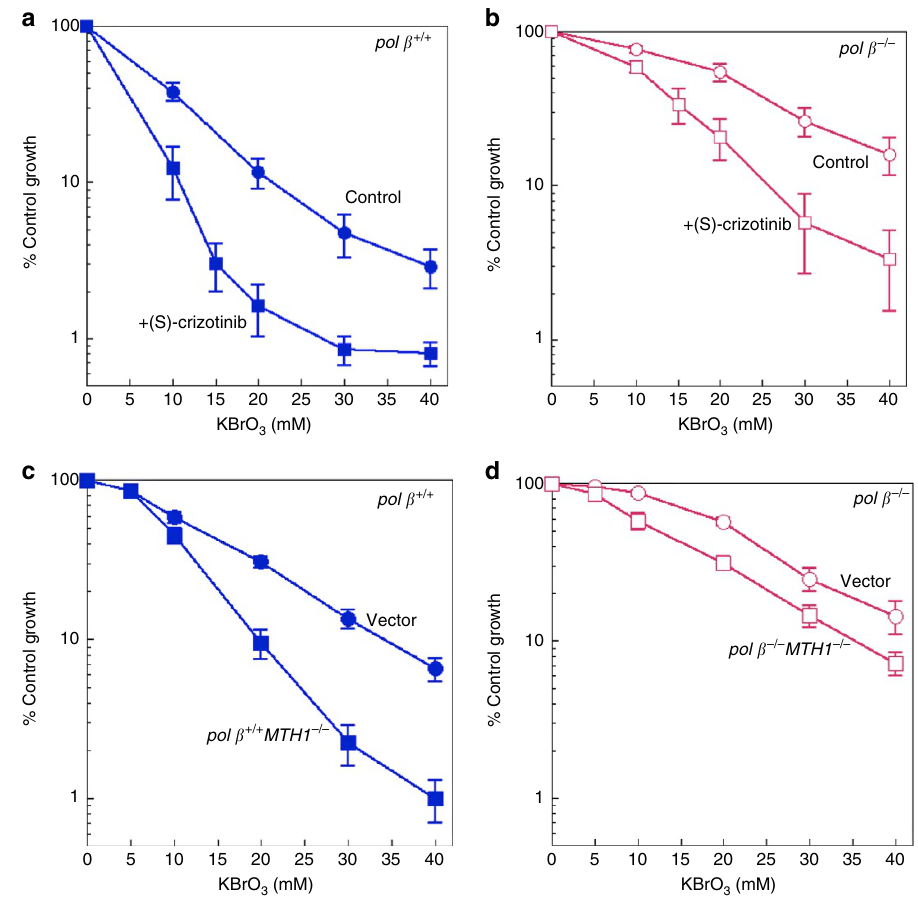
Figure 3 | Sensitivity of MEFs to oxidative stress. ( a , b ) Plots show pol b þ / þ and pol b (cid:2) / (cid:2) cells treated with a range of concentration of KBrO 3 (control) and KBrO 3 plus (S)-crizotinib (6 m M) continuously. The data represent mean values from three independent experiments. The effect of (S)-crizotinib alone (0–10 m M) in pol b þ / þ and pol b (cid:2) / (cid:2) cells is presented in Supplementary Fig. 3. Sensitivity of pol b þ / þ vector and pol b þ / þ MTH1 (cid:2) / (cid:2) ( c ), and pol b (cid:2) / (cid:2) vector and pol b (cid:2) / (cid:2) MTH1 (cid:2) / (cid:2) ( d ) cells to a 1h exposure to KBrO 3 . Cells transfected with empty lentivirus vector, Lenti-eSpCas9, were used as controls for analysis. The data represent mean values with the s.d. from three or four independent